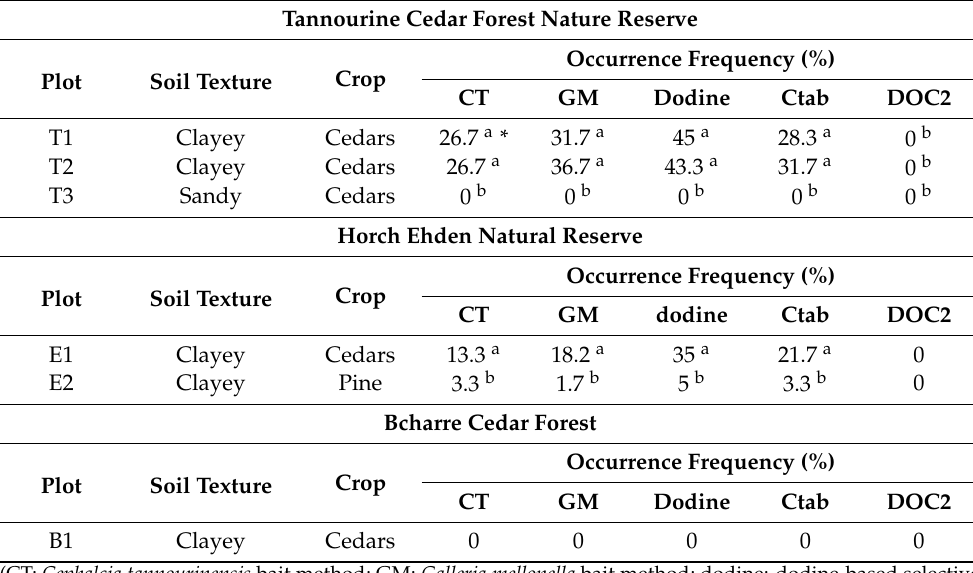
Table 2. Occurrence frequency of Beauveria EPF recovered from soil samples.